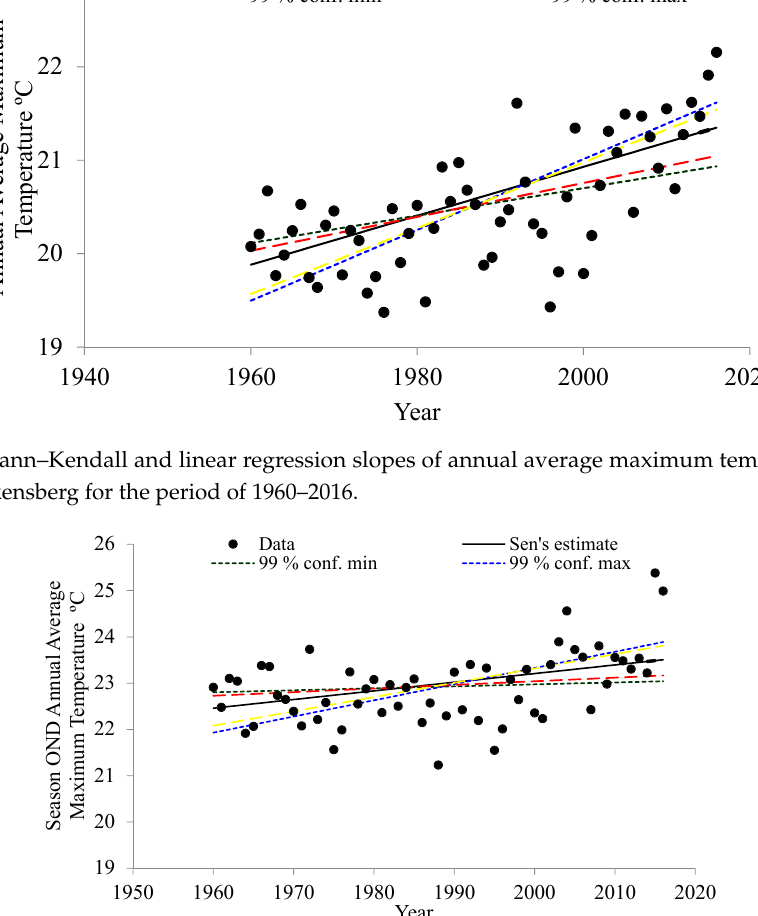
Figure 8. Mann–Kendall and linear regression slopes of annual average minimum temperature for Maloti-Drakensberg for the period of 1960–2016.